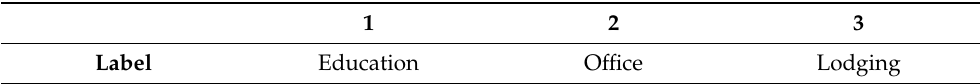
Figure 5. ( a ) Education building gas pattern; ( b ) Matrix Profile with top 10 discords. Table 1. Identification